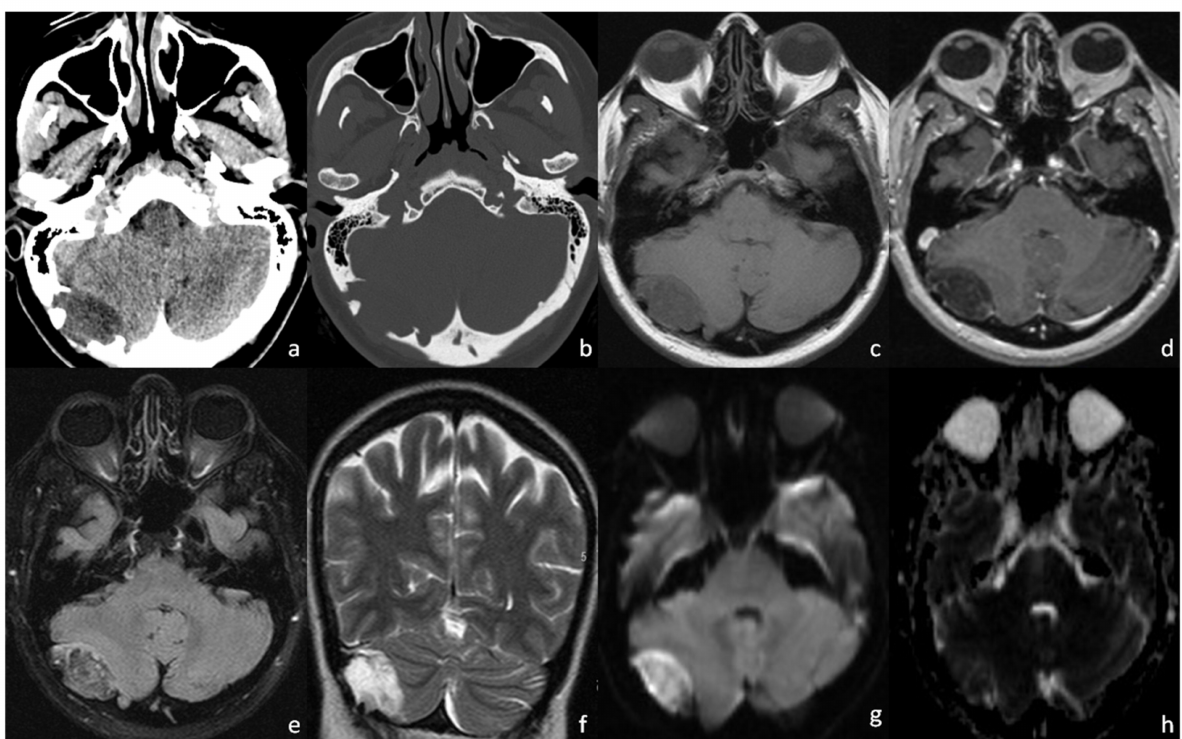
Figure 3. Case 3: CT scan ( a , b ) showing a thecal-centered, inhomogenously hypodense mass causing bone remodeling and focal areas of bone erosion. The 1,5 T MRI ( c – h ) of the lesion, which appears unevenly hypointense on T1WI ( c ), and hyperintense on T2WI ( f ). There is incomplete fat saturation on FLAIR ( e ) and on post-contrast 3D T1 MPRAGE ( d ); and poor restricted diffusion on DWI/ADC ( g , h ). On 3D T1 MPRAGE ( d ) subtle contrast enhancement of the capsule and some thin internal septa may be appreciated.